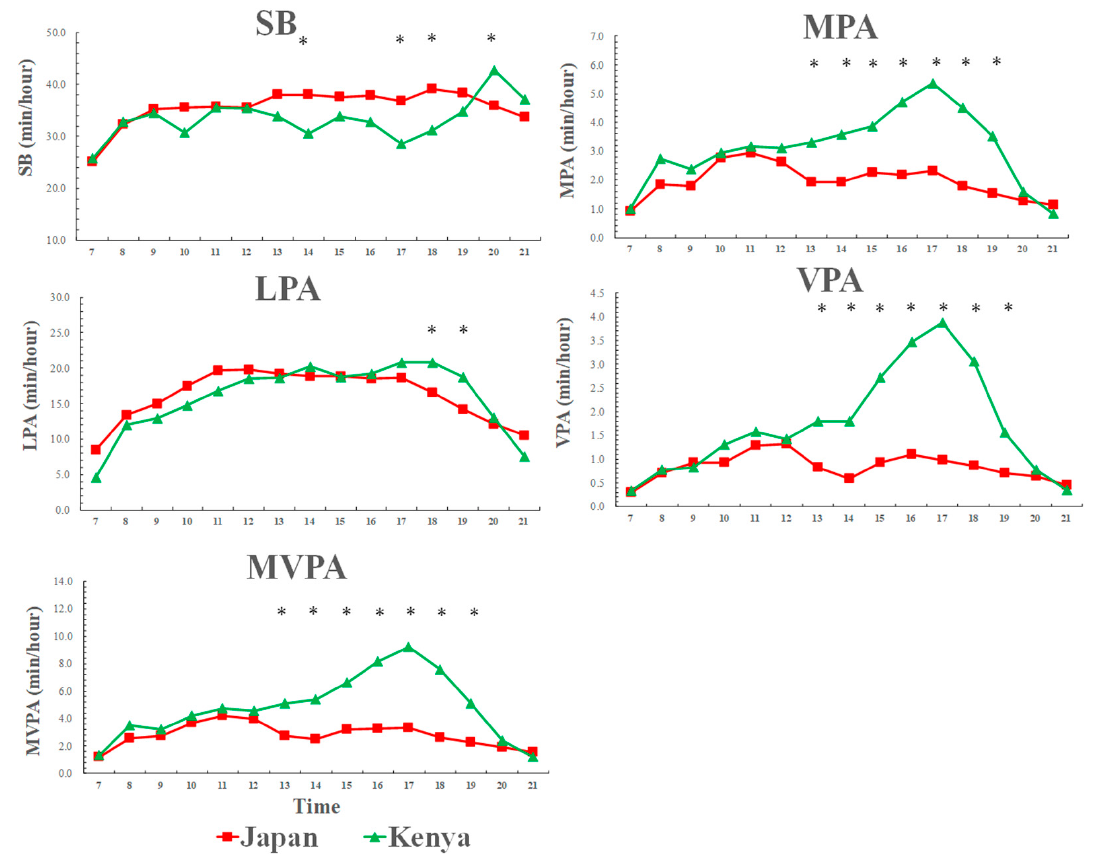
Figure 4. Weekend physical activity and sedentary behavior patterns across a day among Kenyan and Japanese